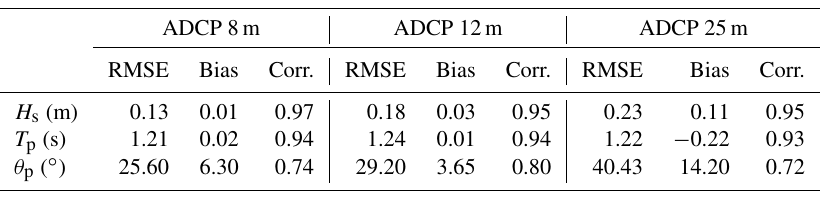
Table 2. Comparison between SWAN results and nearshore wave observations in the Cala Millor beach. The period spanned by the series is from 14 March to 14 April 2014.